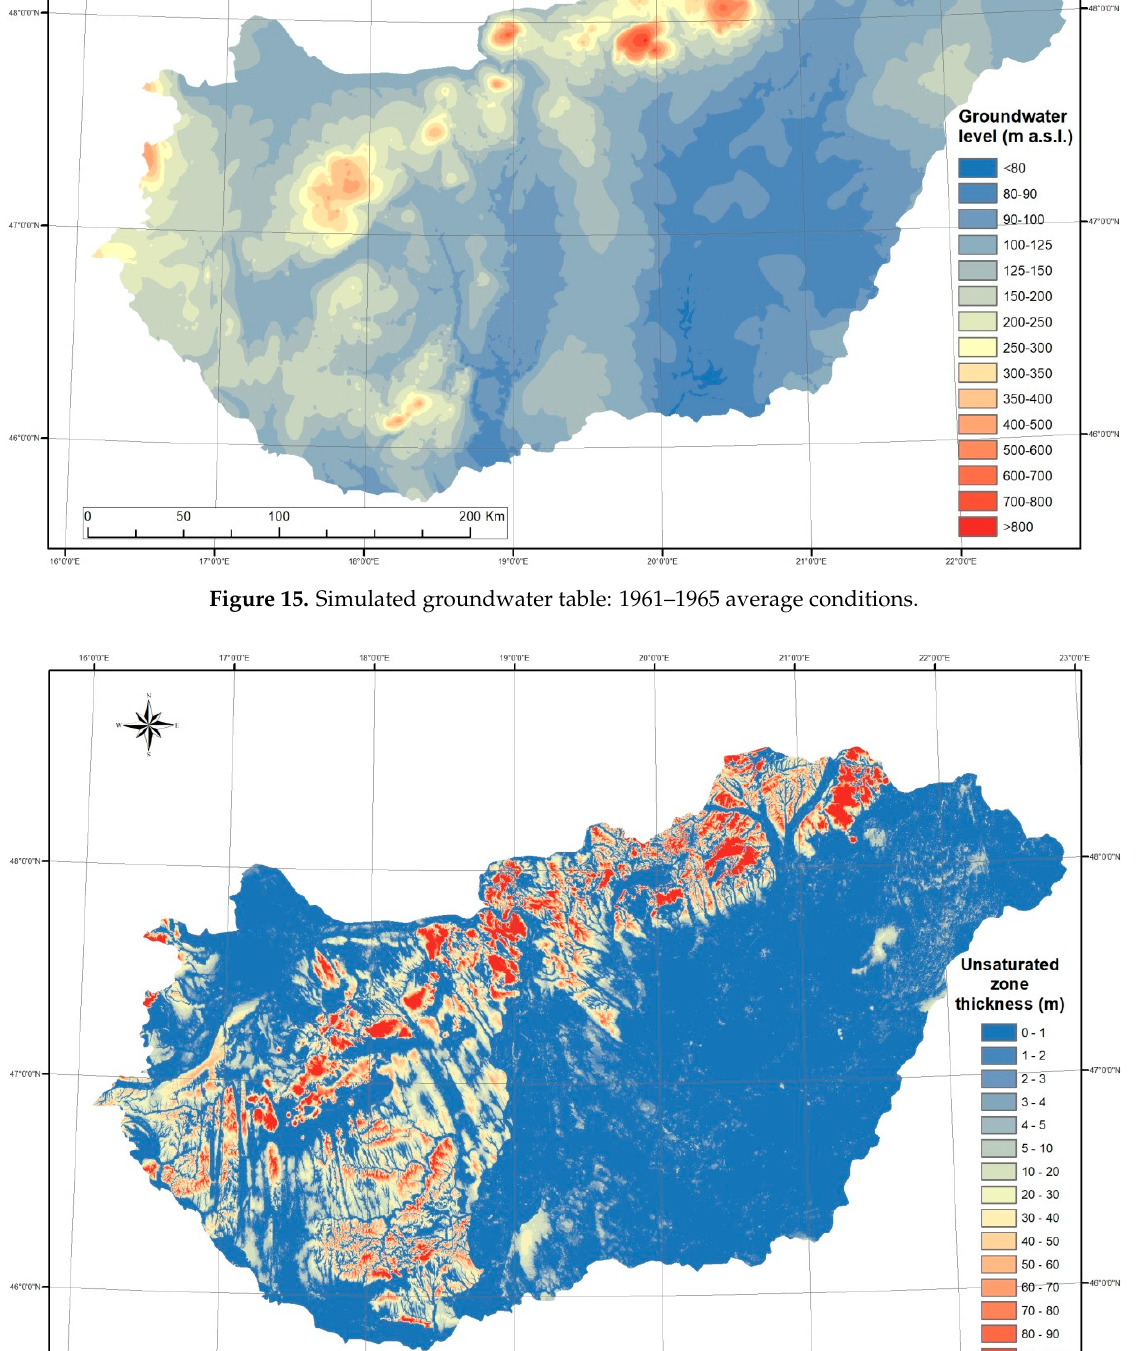
Figure 17. Simulated difference in groundwater table between 2021–2050 and 1961–1990 averages based on ALADIN model results.